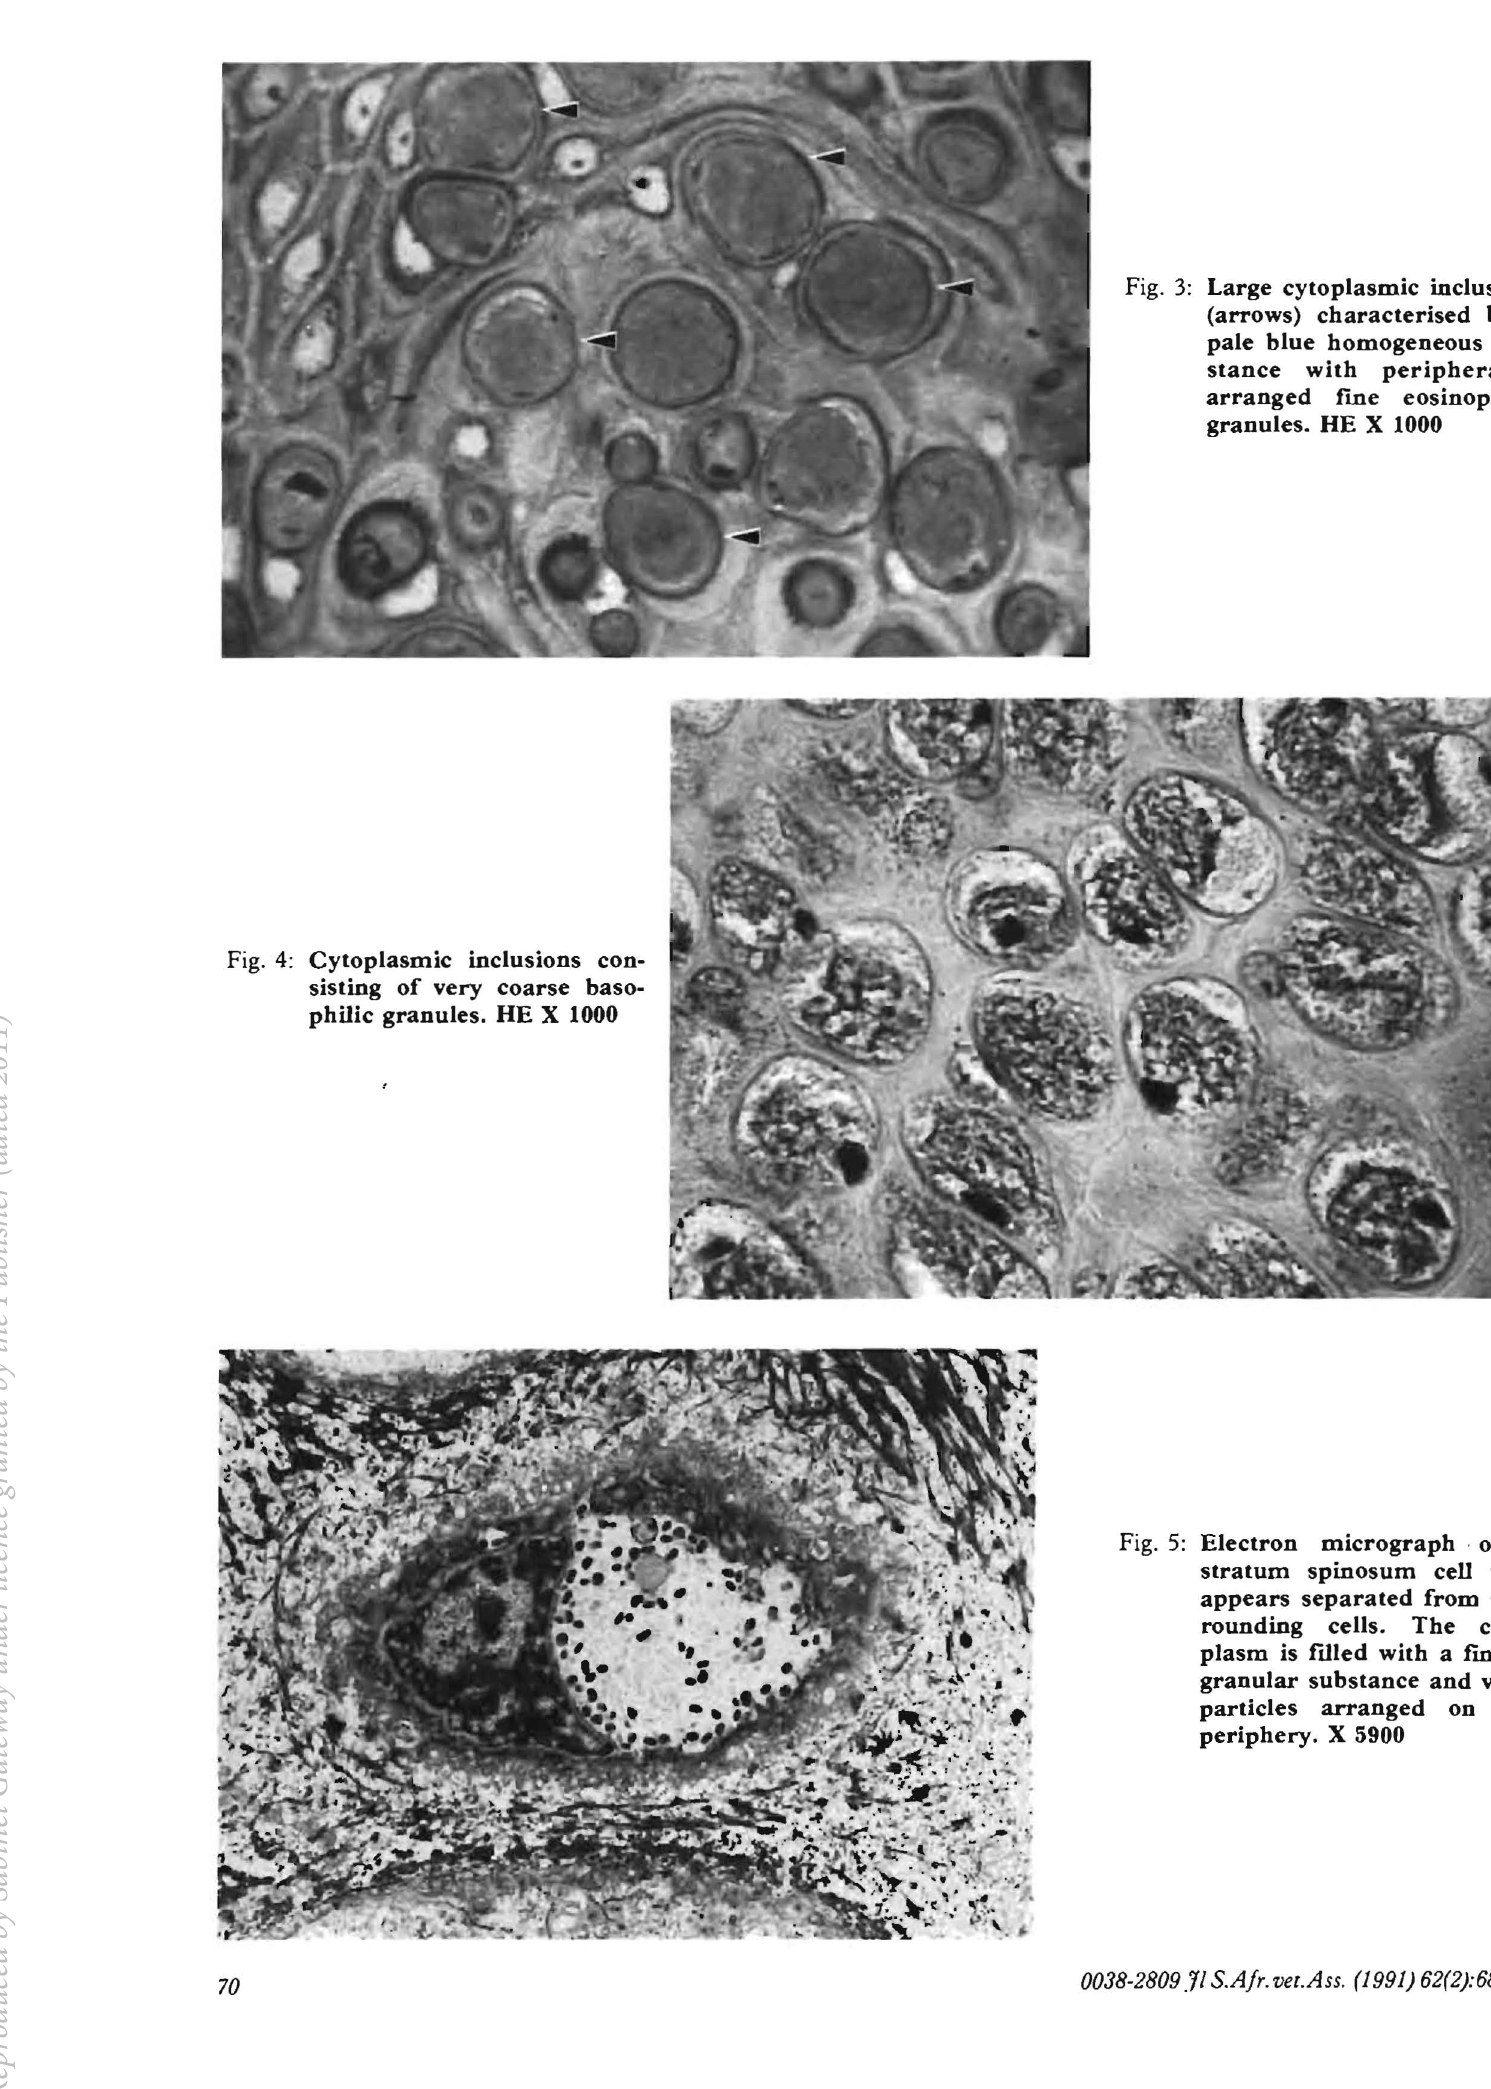
Fig. 3: Large cytoplasmic inclusions (arrows) characterised by a pale blue homogeneous sub stance with peripherally arranged tme eosinophilic granules. HE X 1000